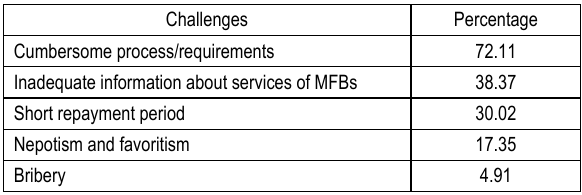
Table 2. Challenges faced by SMEs in accessing finance from